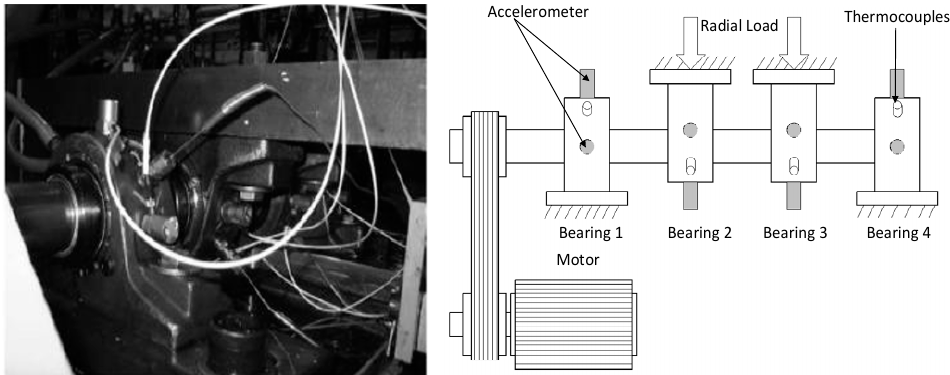
Figure 4. Test rig of Intelligent Maintenance Systems (IMS).